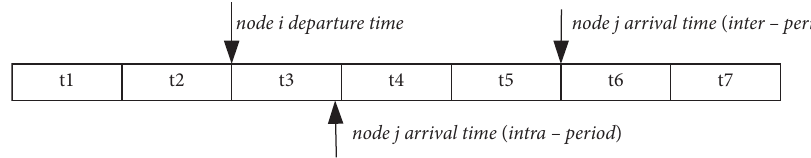
Figure 4: Schematic diagram of intraperiod and